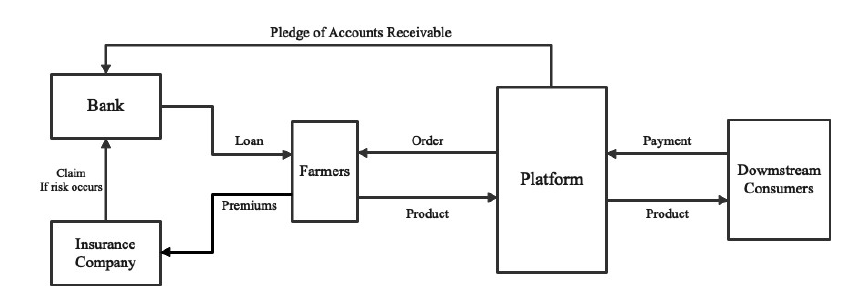
Figure 8. “Platform + Insurance + Order Financing”